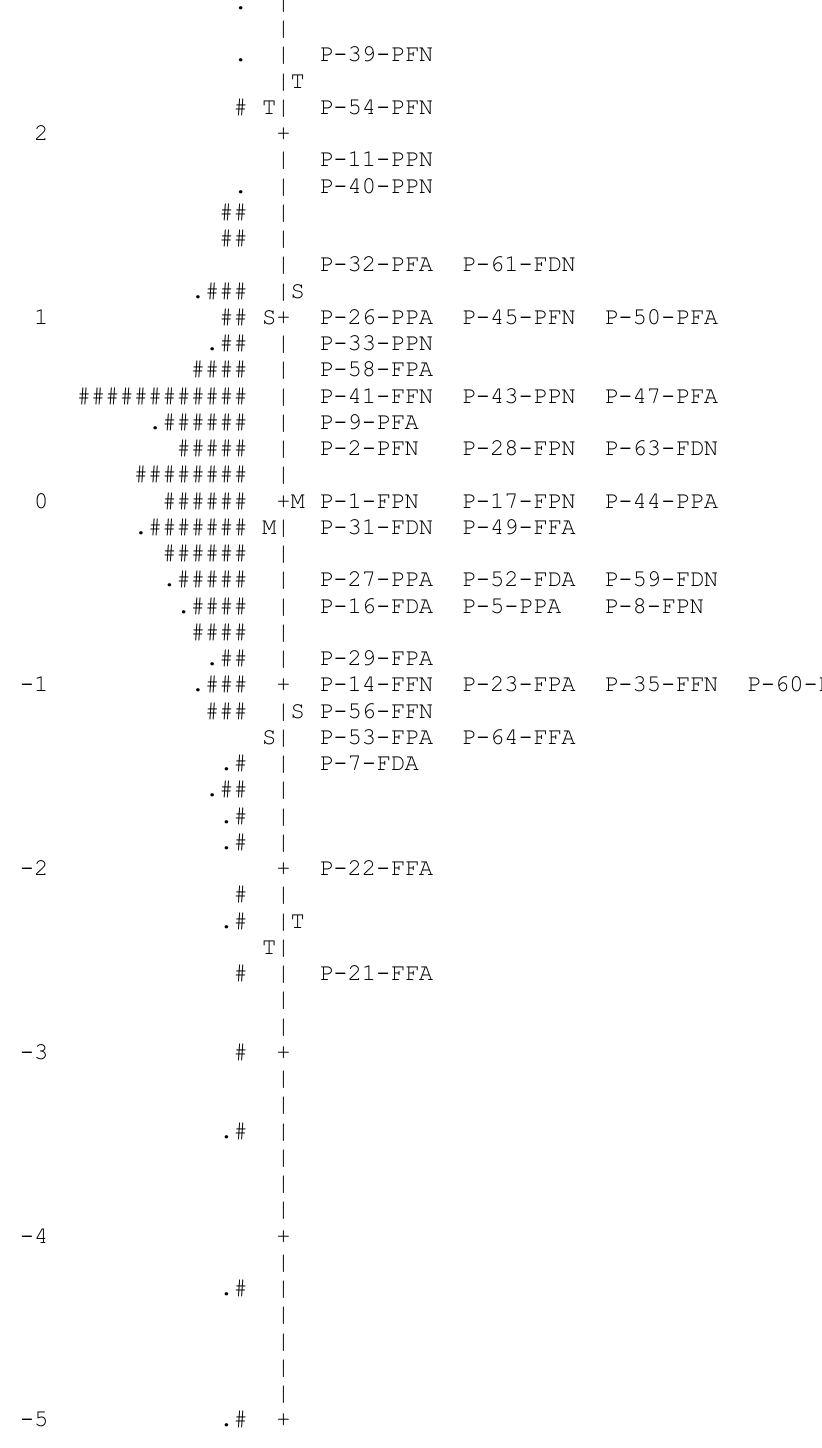
Figura 6 . Mapa do construto para o teste de pares. Nota . Cada “#” são 2. Cada “.” é